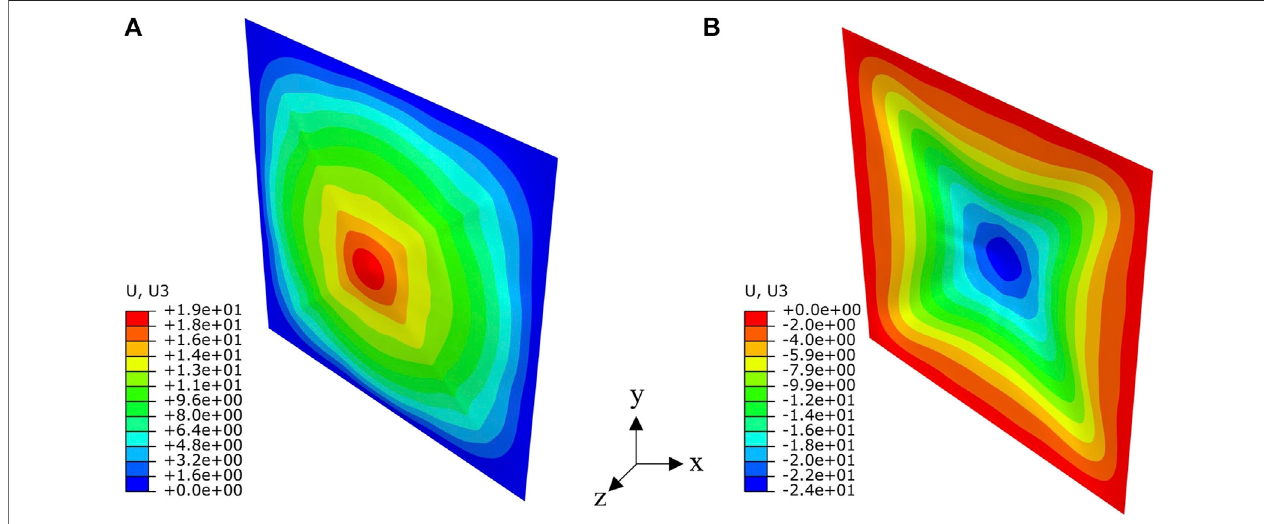
FIGURE5| DynamicresponsesofFMLplatesundertheimpulsiveloadof Z (cid:2) 1 . 82 m / kg 1 / 3 . (A) Thede fl ectiontimehistoriesattheplatecenter. (B) Comparisonof maximum positive de fl ection and fi nal de fl ection between aluminum and FML plates.